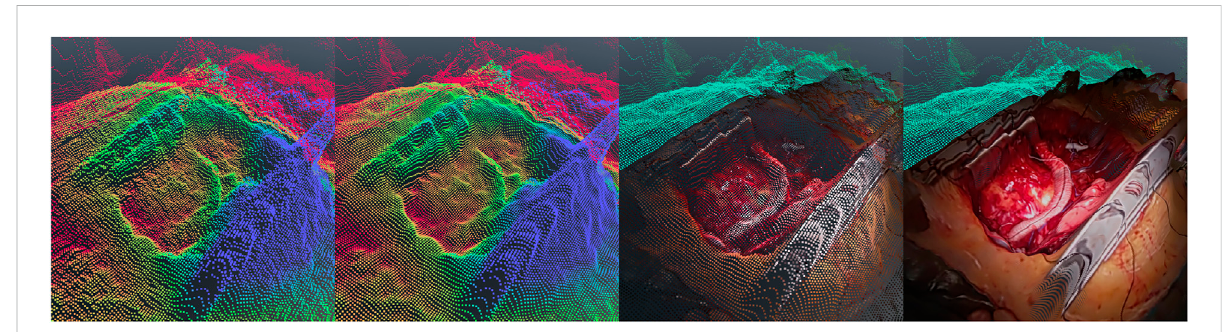
FIGURE 8 Visualization of different steps of the point cloud reconstruction. From left to right: (1) depth map (the distance to sensor is mapped to point colorwithblueforclosepointtoredforfarpoints),(2)reconstructionafterGaussian fi ltering,(3)RGBvideostreammappedtodepthpixelsand(4)the result of sub pixel bilinear